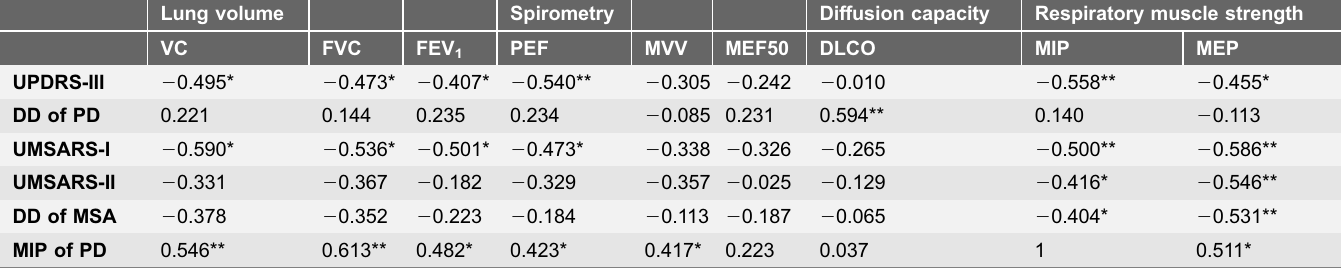
Table 2. The Liner Correlation between Main Part of Respiratory Function Tests (RFT) Values with Severity of Motor Symptoms and Disease Duration of Patients with Parkinson’s Disease (PD) and Multiple System Atrophy (MSA). Lung